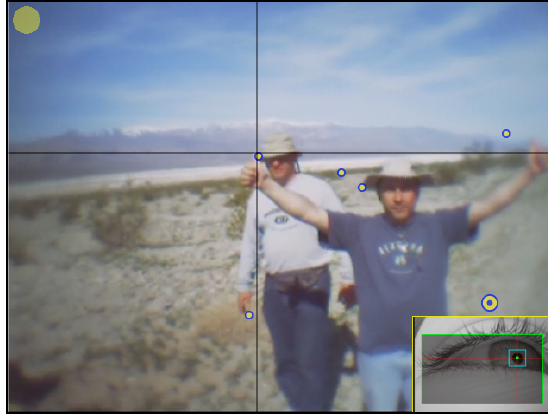
Figure 6. Head tick calibration method. The observer is looking at a stationary target held by a partner, and the dots indicate all positions the observer paused for a head